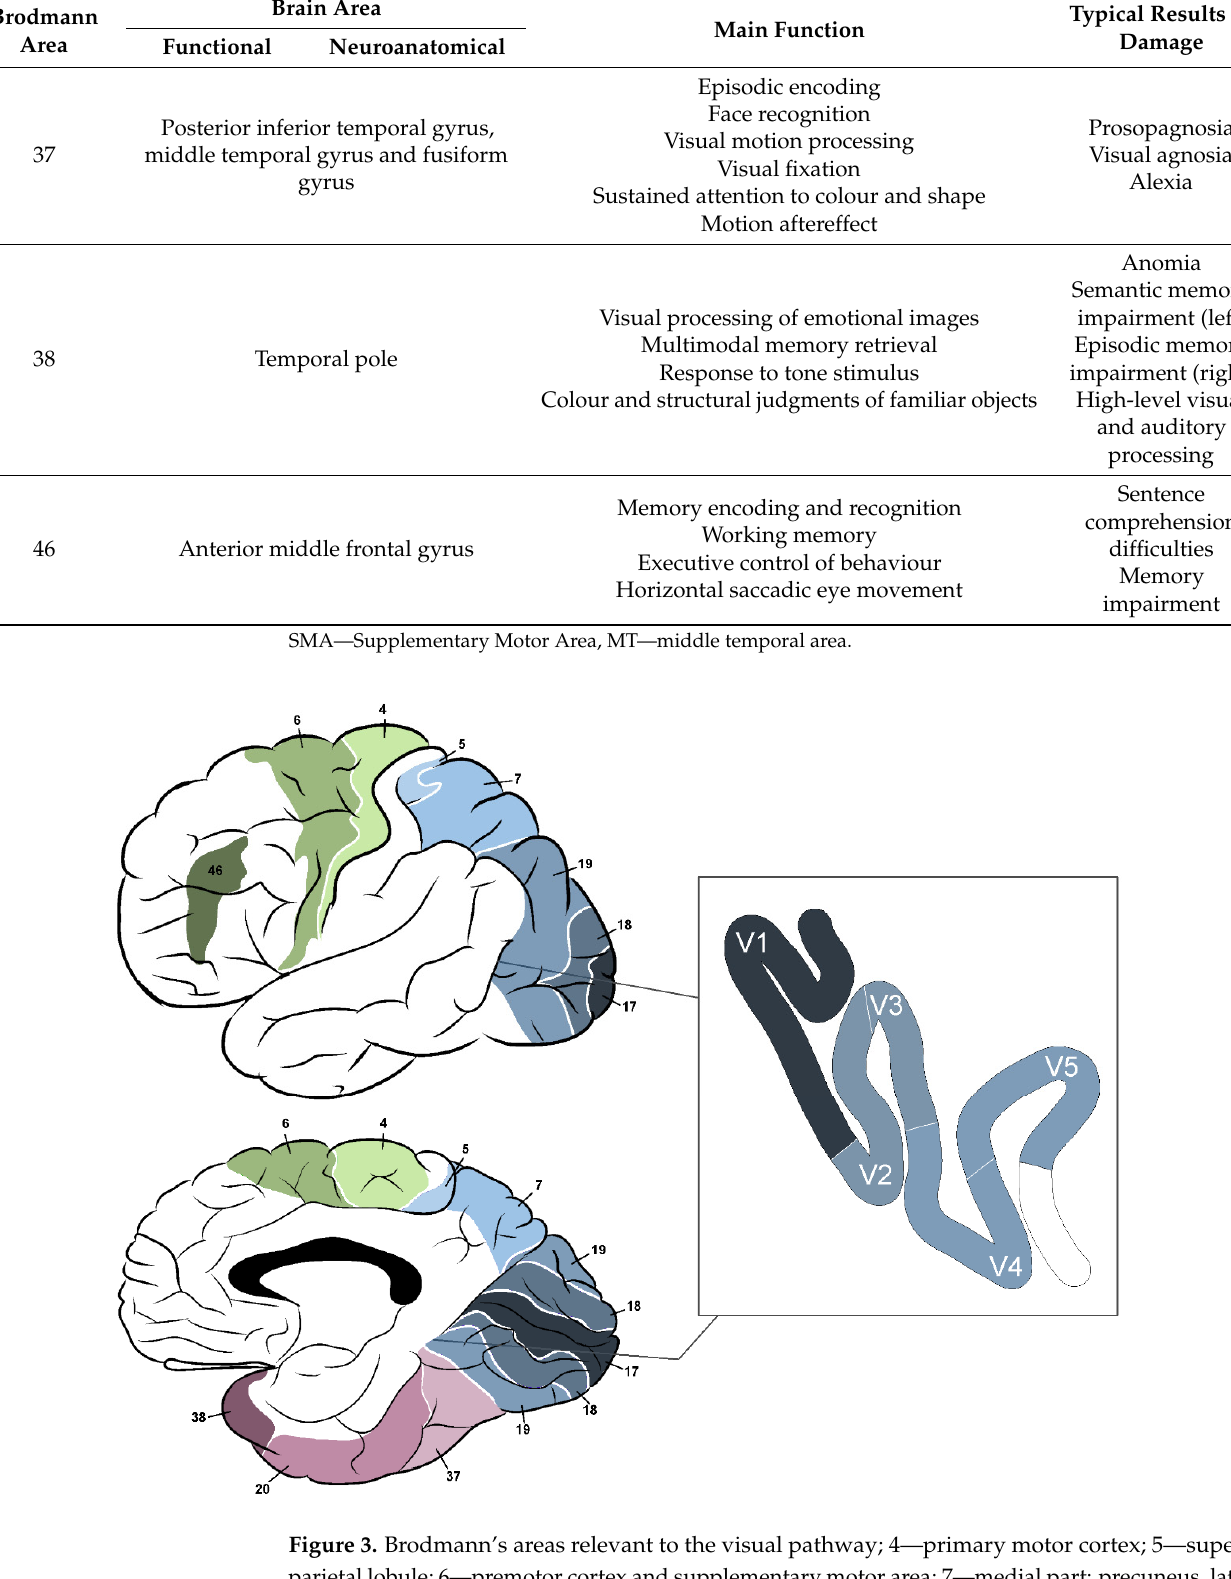
Table 1. Brain regions associated with visual pathways, their location, function and the most common effects of damage [35-38].